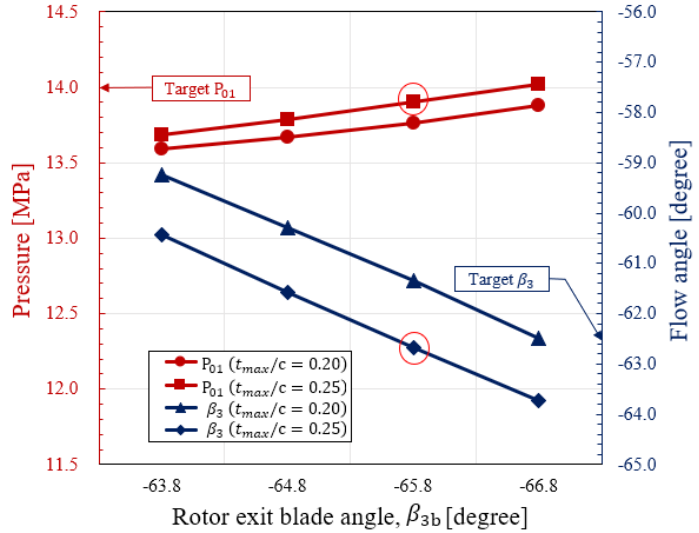
Figure 11. Pressure ( P 01 ) and flow angle ( β 3 ) according to the first-stage rotor optimization of the radial outflow turbine.